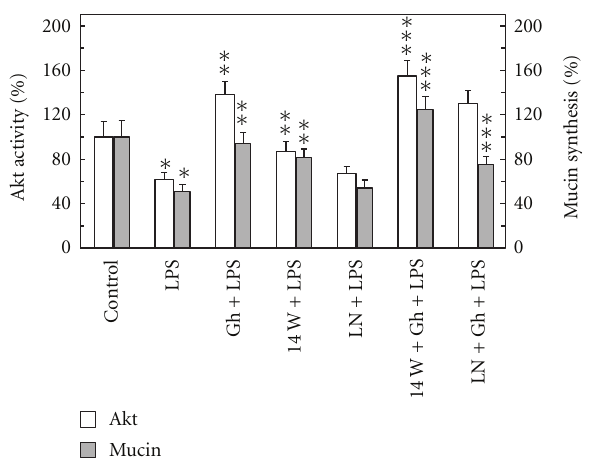
Figure 7: E ff ect of Akt inhibitor, SH-5, and ascorbate on the ghrelin- (Gh-) induced changes in mucin synthesis and Akt activity in the acinar cells exposed to P. gingivalis LPS. The cells, preincubated with 20 μ M SH-5 (SH) or 300 μ M ascorbate (As), were treated with Gh (0.6 μ g/mL) and incubated for 16h with the LPS at 100ng/mL, in the presence of [ 3 H]glucosamine as a marker of mucin synthesis. ∗ P < . 05 compared with that of control. ∗∗ P < . 05 compared with that of LPS alone. ∗∗∗ P < . 05 compared with that of Gh +